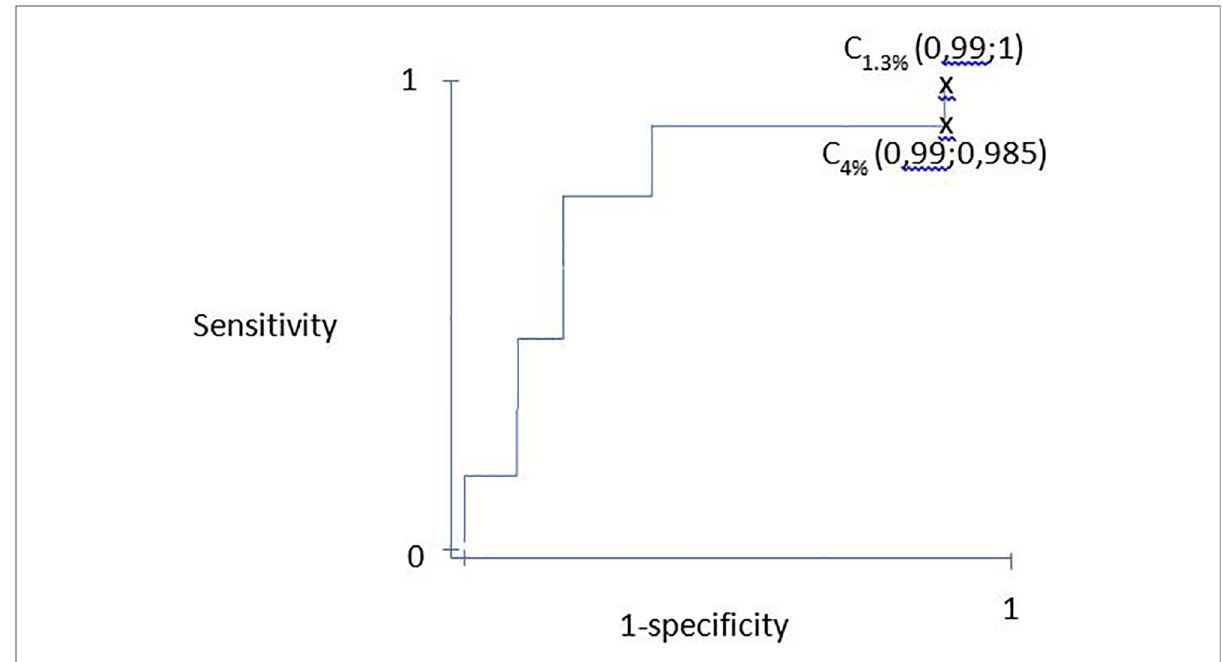
FIGURE 1 ROC curve example based on tableau 1. ROC, Receiver operating